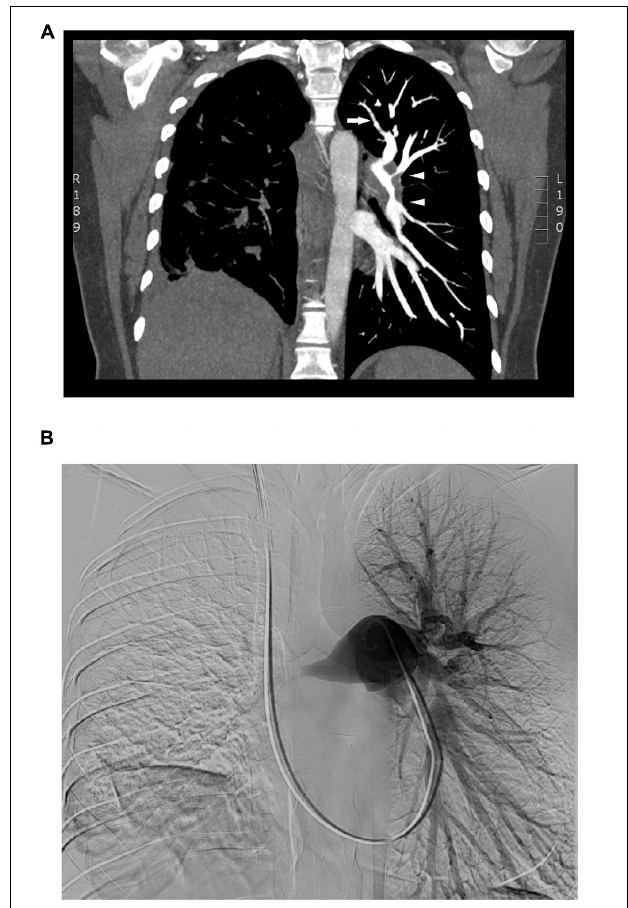
FIGURE 2 | Right pulmonary artery biopsy. Histologic examination (hematoxylin and eosin stain) of the right pulmonary artery biopsy revealed fibrotic connective tissue (A) infiltrated by inflammatory cells consisting of lymphocytes and macrophages (B,C) . Immunohistochemistry was carried out for the leukocyte common antigen CD45 (D,E) , immunoglobulin subclass IgG4 (F,J) and a lymphocyte specific transcriptional factor: multiple MUM1 (H,I) . Total magnification of 40 × (A) and 400 × (B–I)